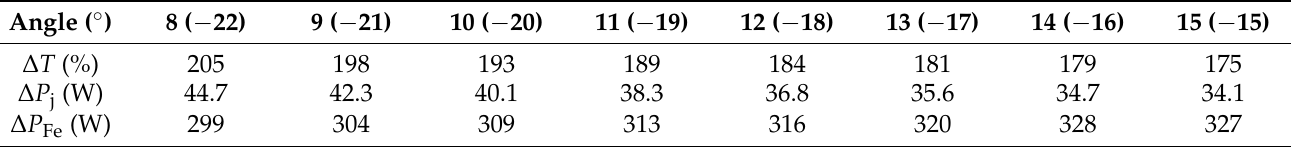
Table 3. Torque ripple and losses for different advance angles for a rotor pole arc of 34 ◦